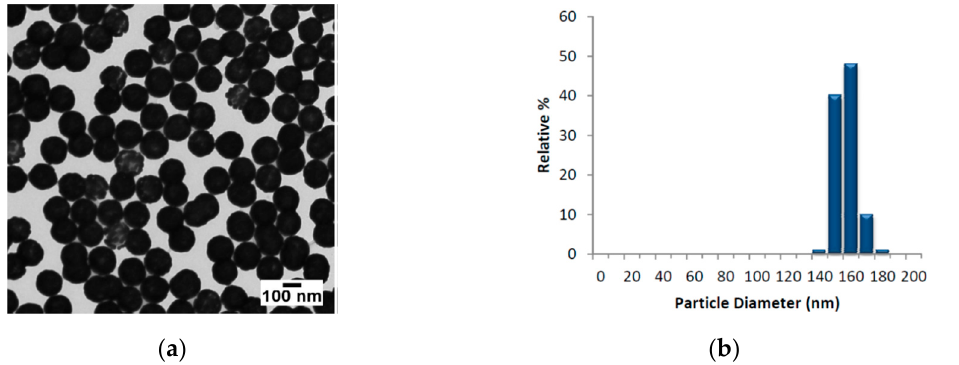
Figure 1. Transmission electron microscopy image of the gold nanoshells (AuNSs) ( a ); correspondent size distribution ( b ).